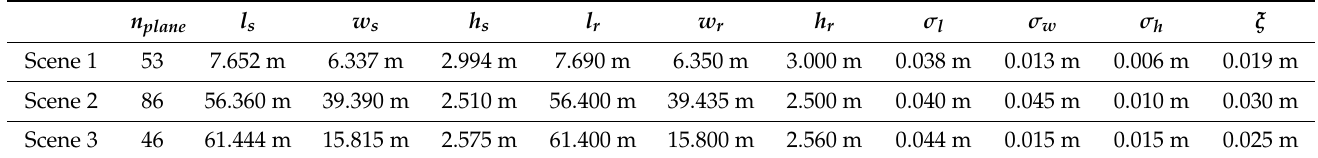
Table 9. Parameter comparison between the actual scenario and the predicted scenario. n plane